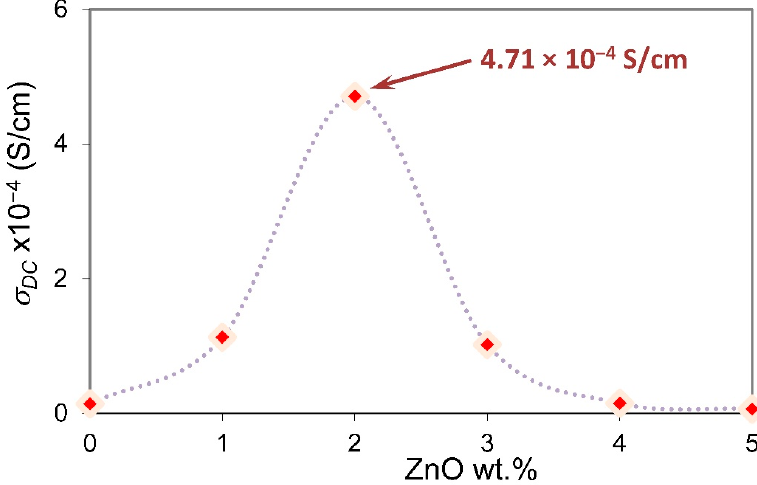
Figure 6. Ionic conductivity as a function of ZnO wt.% at room temperature .